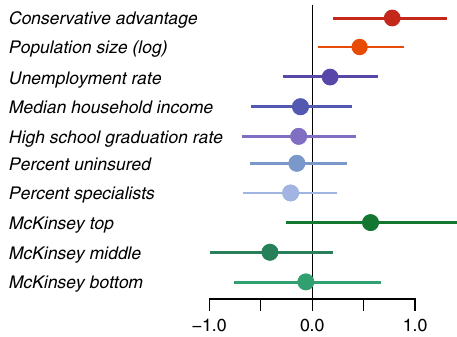
Fig. 3 Coef fi cient estimates for regression of r k against key state-level factors (Model 5). Conservative advantage and population size (warm colors) were signi fi cantly and positively associated with r k at the 0.01 level. None of the other factors (socioeconomic in blues; health in greens) were signi fi cantly associated with r k . Values close to ±1 indicate a strong relationship with r k for continuous variables. Error bars show Normal two- sided 99% con fi dence